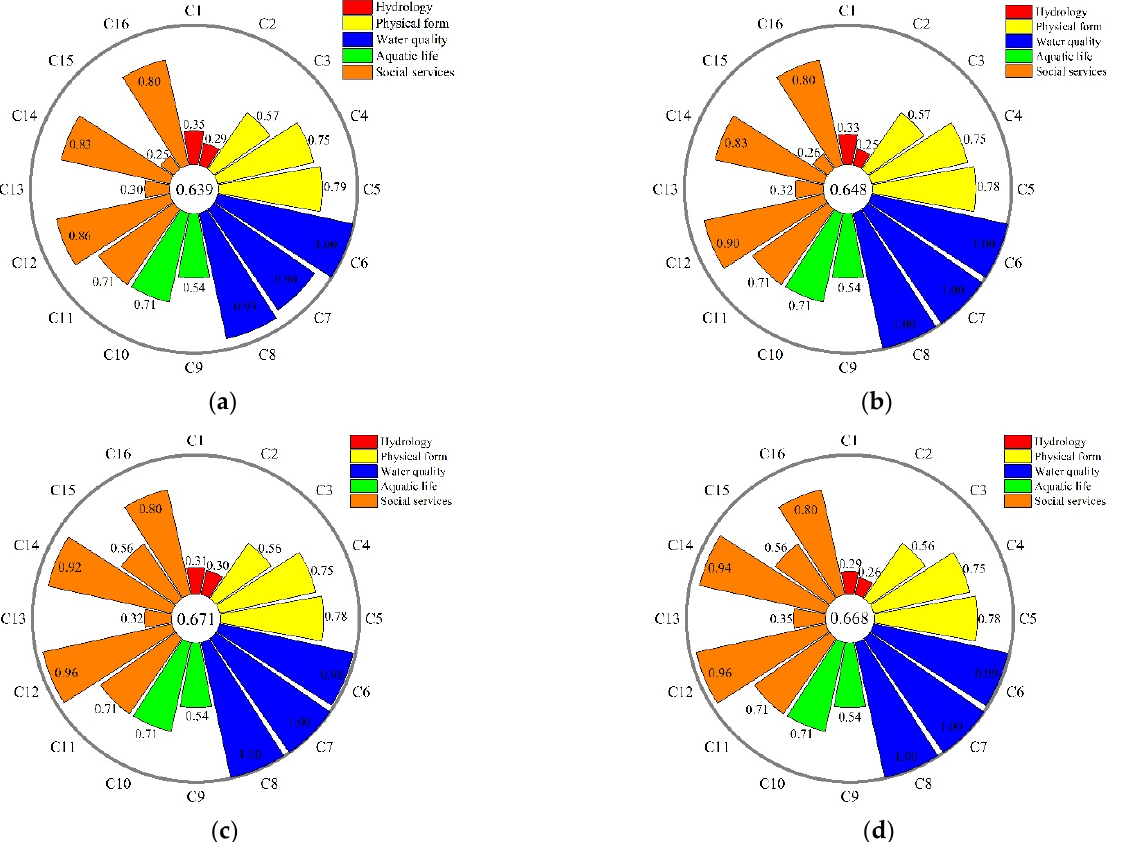
Figure 3. The annual variability of each index in the Lhasa River health assessments in ( a ) 2011; ( b ) 2012; ( c ) 2013; and ( d ) 2014.